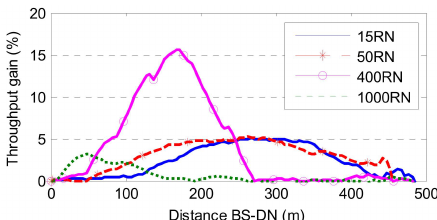
Figure 14. Throughput gain obtained with BRISK-R with respect to BRISK-C—web tra ffi c & circularly symmetric scenario.